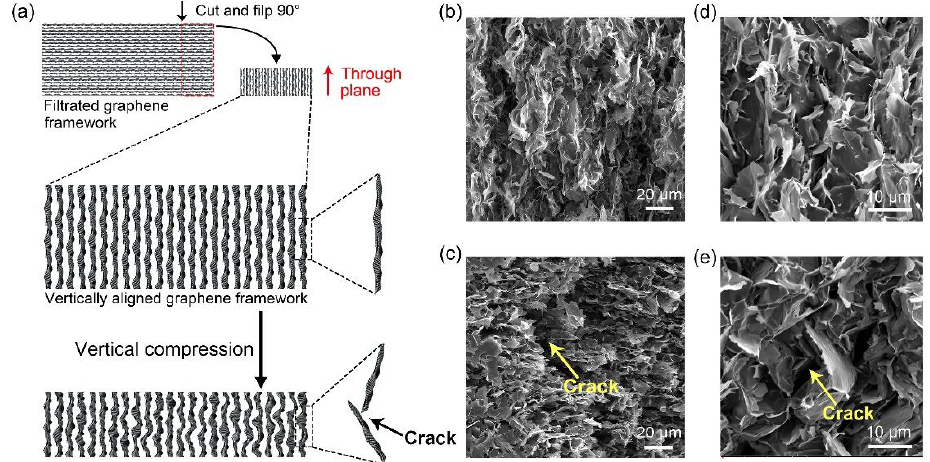
Figure 4. ( a ) Schematic illustrating the fabrication of vertically aligned and densely packed graphene framework and the structure of the framework was destroyed after applying a vertical compression. SEM images of vertically aligned and densely packed graphene framework ( b ) before and ( c ) after compressing. ( d , e ) The case of graphene framework/PDMS composite.